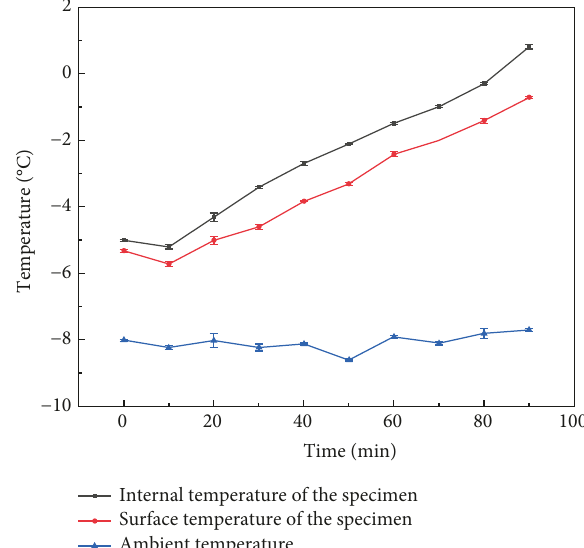
Figure 13: Heating effect of 0.3% carbon fiber +40% graphite rutting plate.